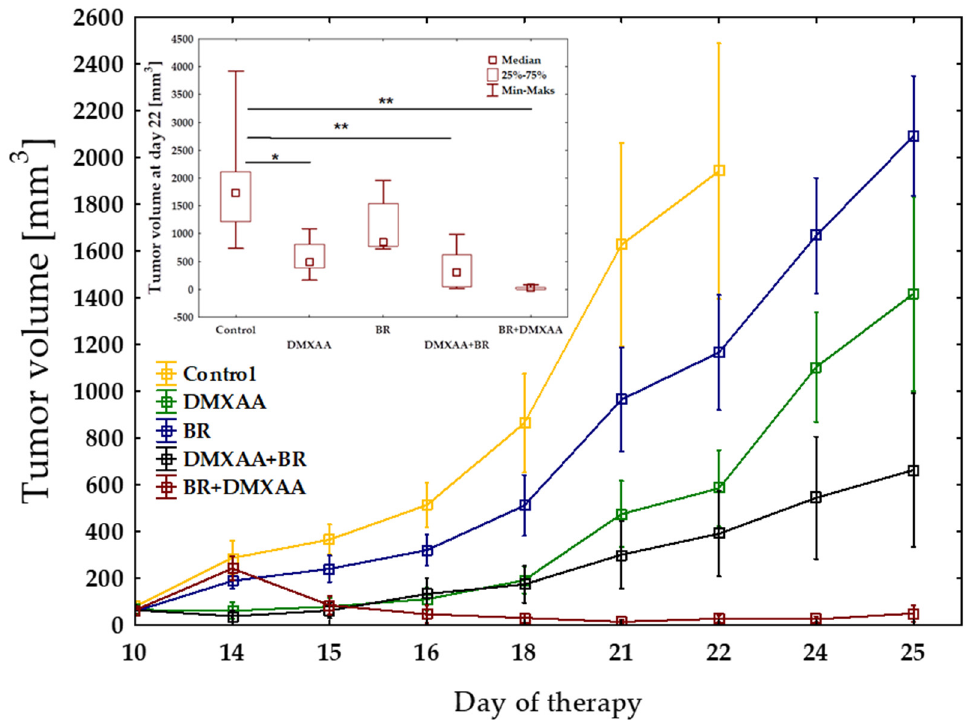
Figure 1. Inhibition of B16-F10 tumor growth using combination therapy of DMXAA and brachytherapy. Mice with tumors were treated with DMXAA (25 mg/kg) (day 10 or 11) and brachytherapy in a dose of 6 Gy in 3 fractional doses (days 10 or 11 and 15, 18). Tumor growth inhibition was measured (mean ± SEM). Statistical analysis was performed at day 22. * p < 0.05, ** p < 0.01 Tukey’s HSD test.